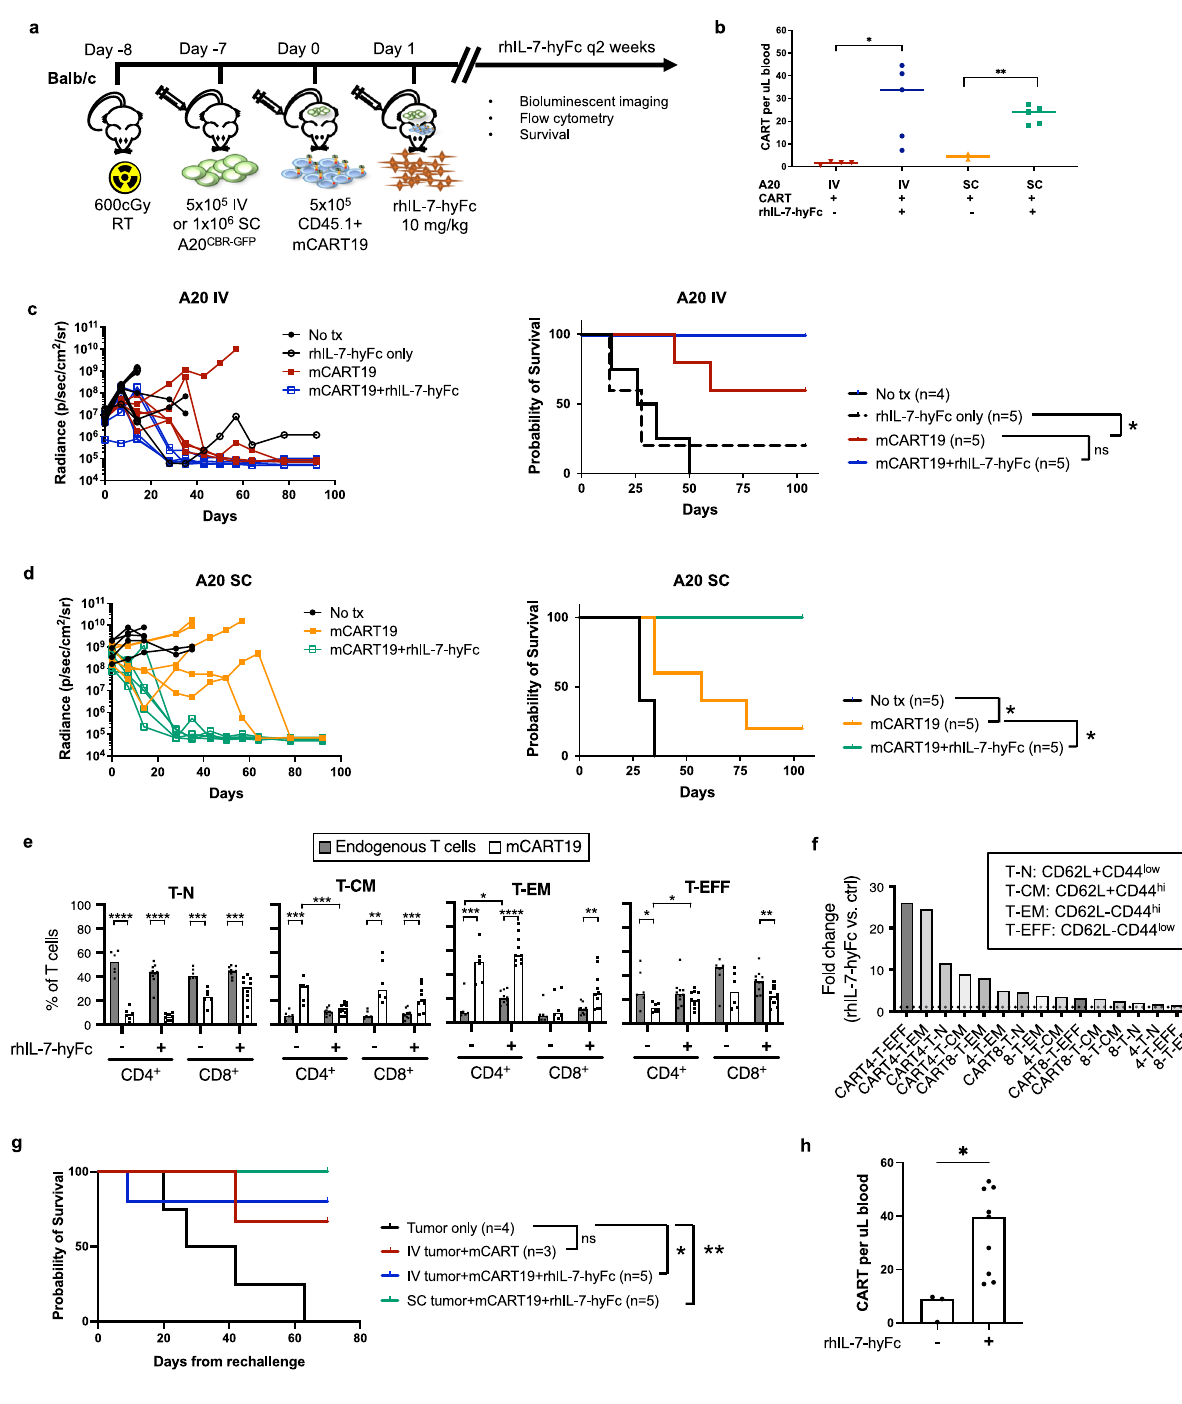
in immunocompetent mice (Fig. 7b). Absolute numbers of mCART19 cells in the spleen were higher after rhIL-7-hyFc treatment, with average cell numbers increasing from day + 7 to day + 14, in contrast to vehicle-treated mice where mCART19 numbers decreased during this time (Fig. 7c). As expected, rhIL-7-hyFc decreased apoptosis (Fig. 7d) and increased pro- liferation (Fig. 7e) of the adoptively transferred T cells. Eva- luation of cytotoxicity (Fig. 7f) and intracellular cytokine production (Fig. 7g) of puri fi ed mCART19 cells against A20 tumor cells revealed enhanced effector functions after exposure to